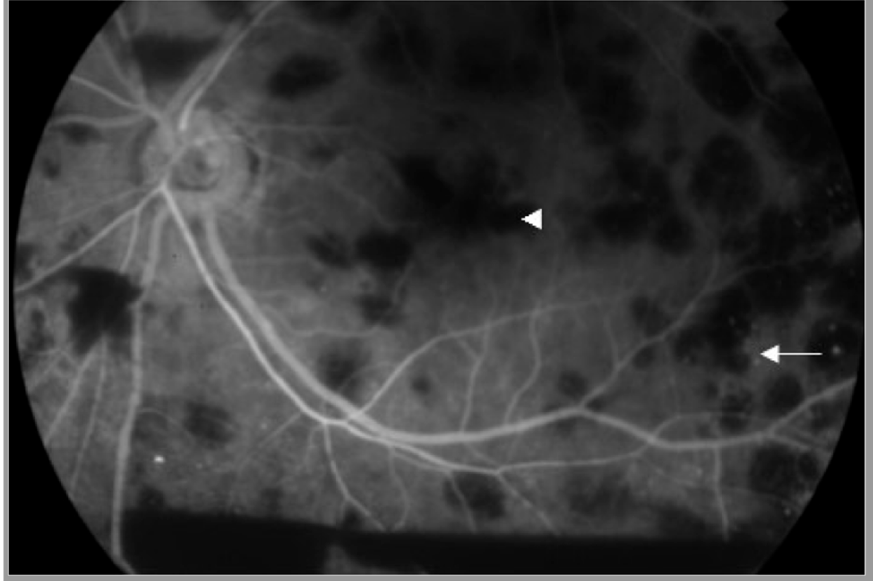
Figure 4. Fluorescein angiography image of the left eye showing multiple areas of blockage of fluo- rescein (white arrowhead). Scattered hyperfluorescent microaneurysms (white arrow) are also noted.